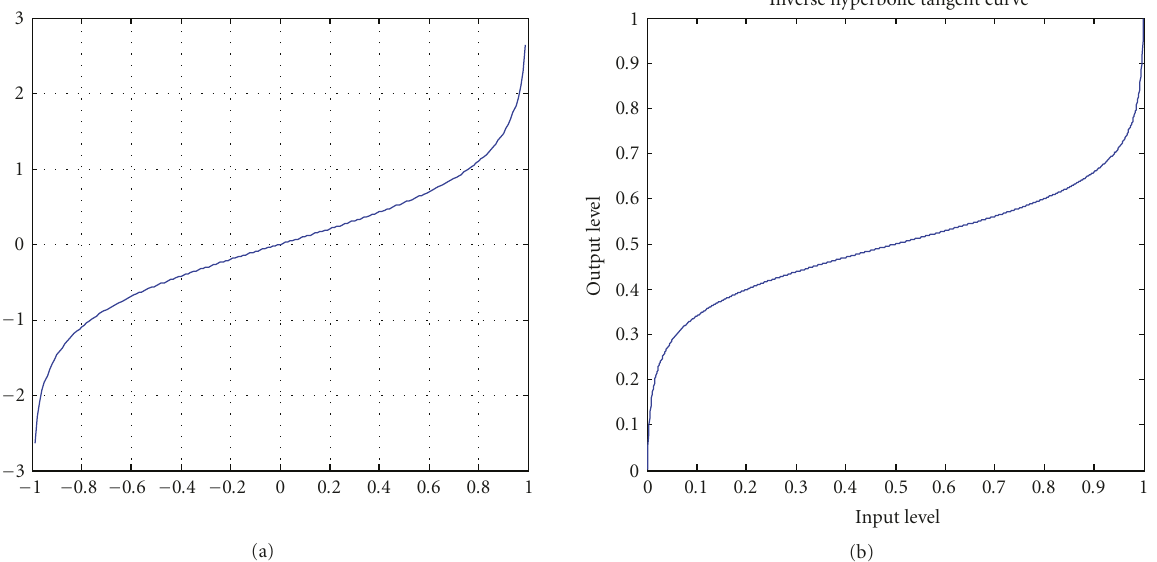
Figure 10: Inverse hyperbolic tangent curve: (a) inverse hyperbolic tangent curve, (b) shift to